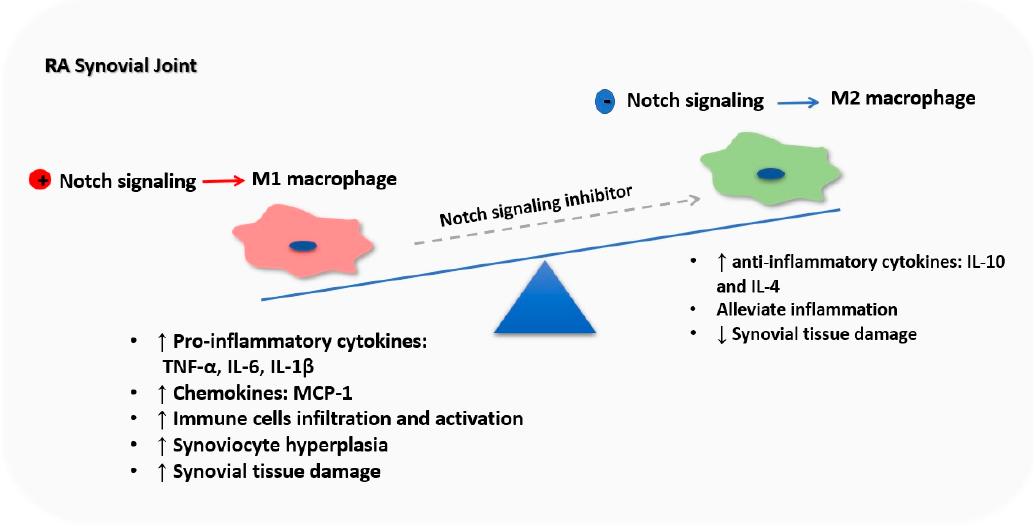
Figure 4. Notch signaling orchestrates macrophage polarization in rheumatoid arthritis (RA) synovial joint. RA synovium microenvironment induces Notch activation in BM-derived macrophages, inducing their M1 polarization. M1 macrophages are the major producer of pro-inflammatory cytokines such as TNF- α , IL-6, and IL-1 β and chemokines such as MCP-1 driving immune cells infiltration and activation, synoviocyte proliferation, tissue destruction and bone loss in the RA synovial joint, which exacerbates RA symptoms. Nevertheless, inhibition of Notch signaling promotes M2 polarization, decreasing M1 macrophages number, and releasing anti-inflammatory cytokines, leading to RA symptoms.